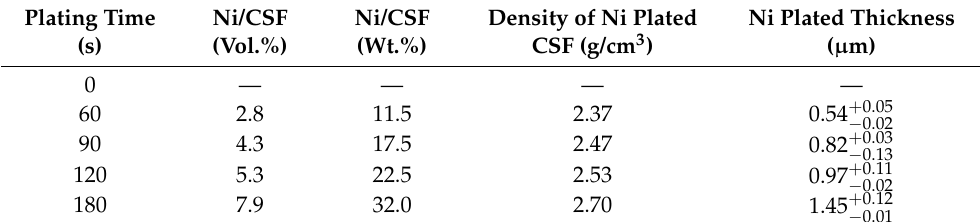
Table 1. Results of Electroless Ni plated CFs with different plating times.